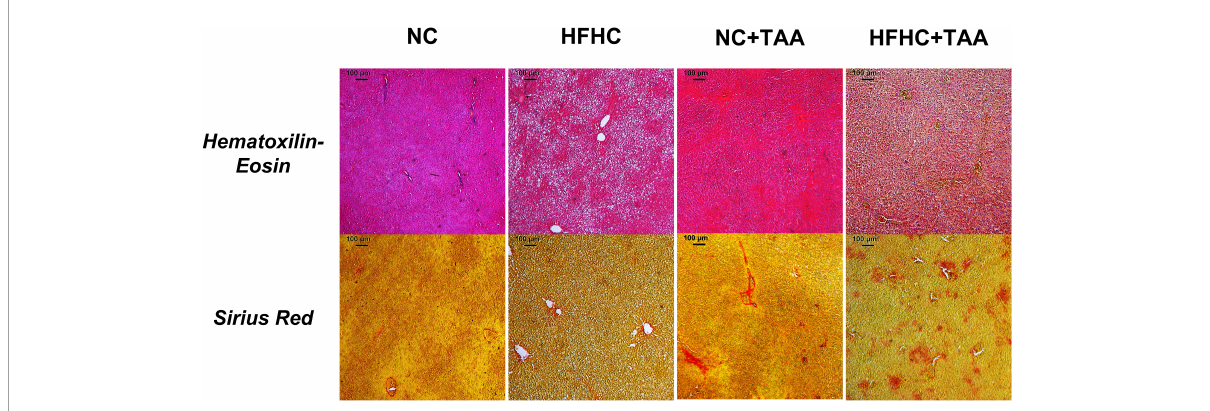
FIGURE3 Microscopic examination (5 × ) of each experimental group. Liver samples were stained with Hematoxylin–Eosin and Sirius Red. HFHC and HFHC + TAA group presented steatosis; moreover, NC + TAA and HFHC + TAA showed progressive fibrosis accumulation and hepatic damage.